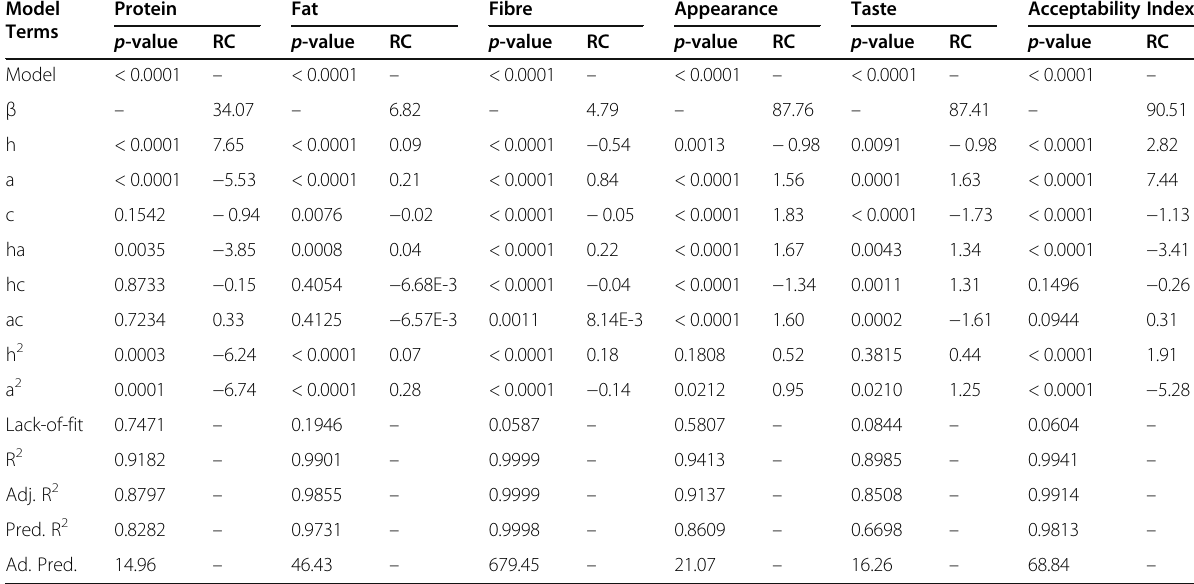
Table 2 Regression analysis of consumer-ready flakes from high-protein soymeal, amaranth and modified corn starch